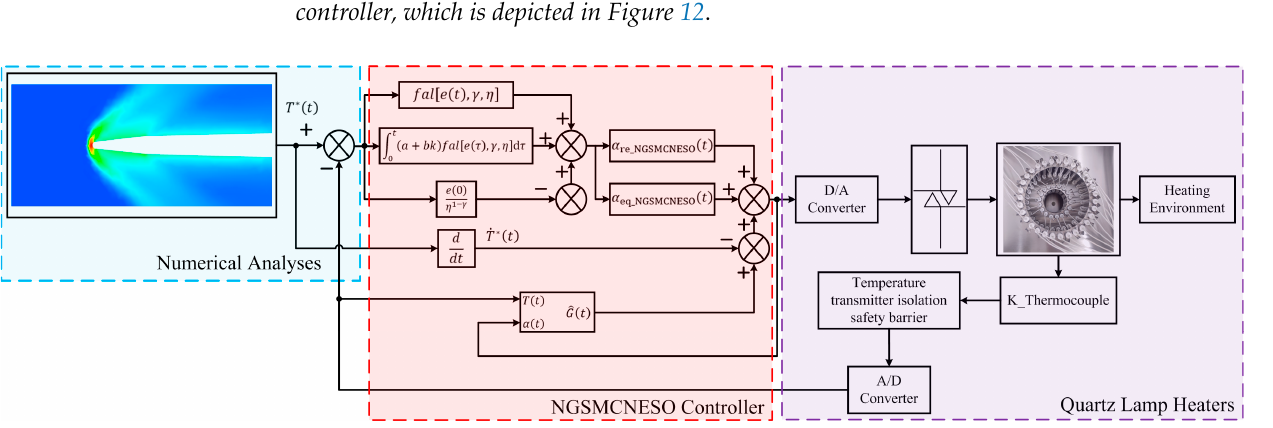
Figure 12. Schematic illustration for the NGSMCNESO controller.